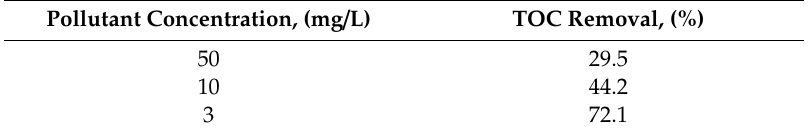
Table 2. TOC removal in the presence of Zn4La400 (500 mg/L) catalyst after 180 min of UV-A irradiation. Pollutant Concentration, (mg/L) TOC Removal, (%)